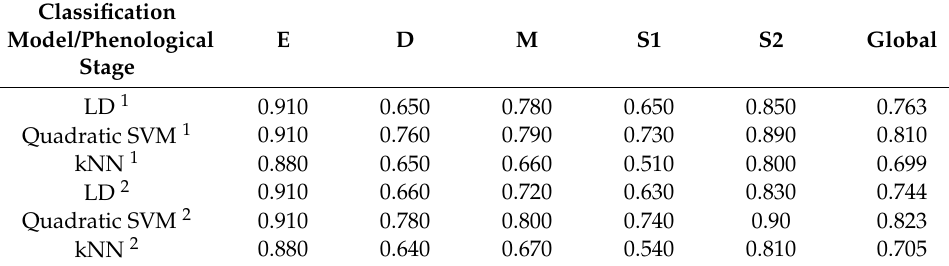
Table 6. Precision of classifiers by class for five phenological